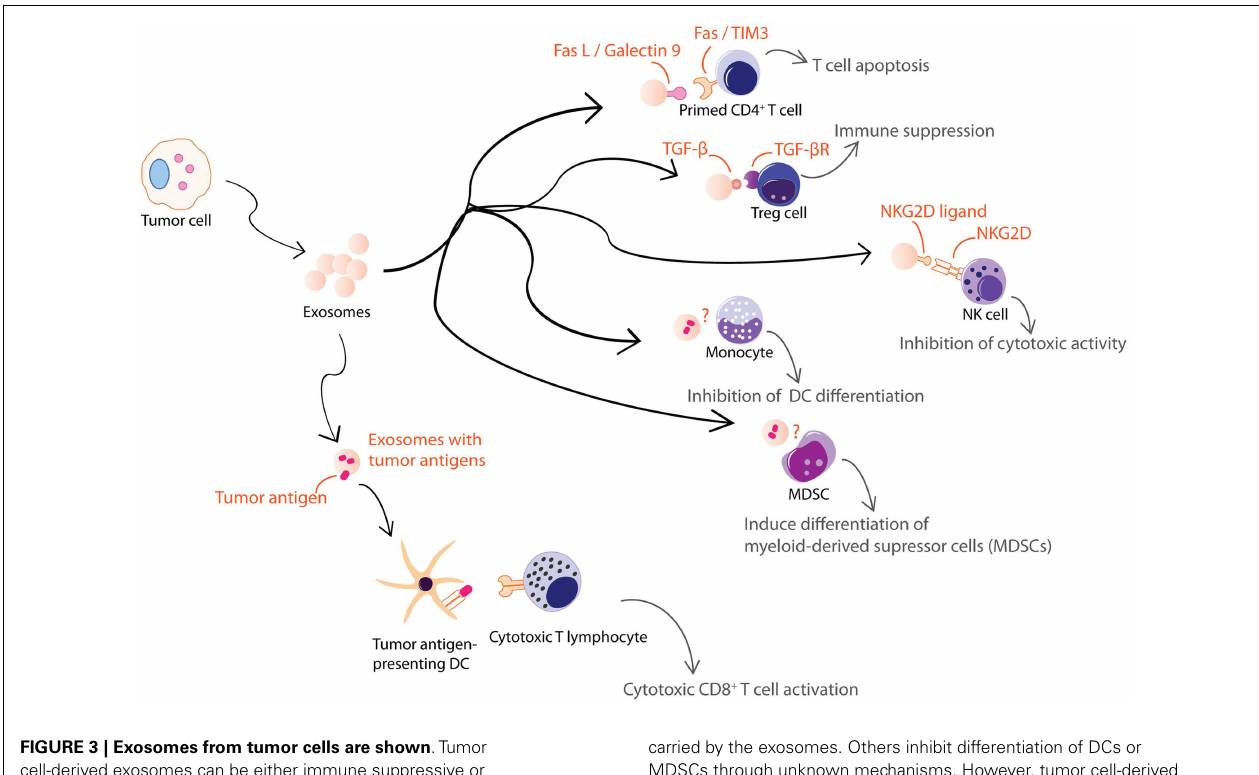
FIGURE 3 | Exosomes from tumor cells are shown .Tumor cell-derived exosomes can be either immune suppressive or activating.These exosomes exert some of their immune suppressive activities onT cells through FasL, galectin-9,TGF β , or NKG2D ligand